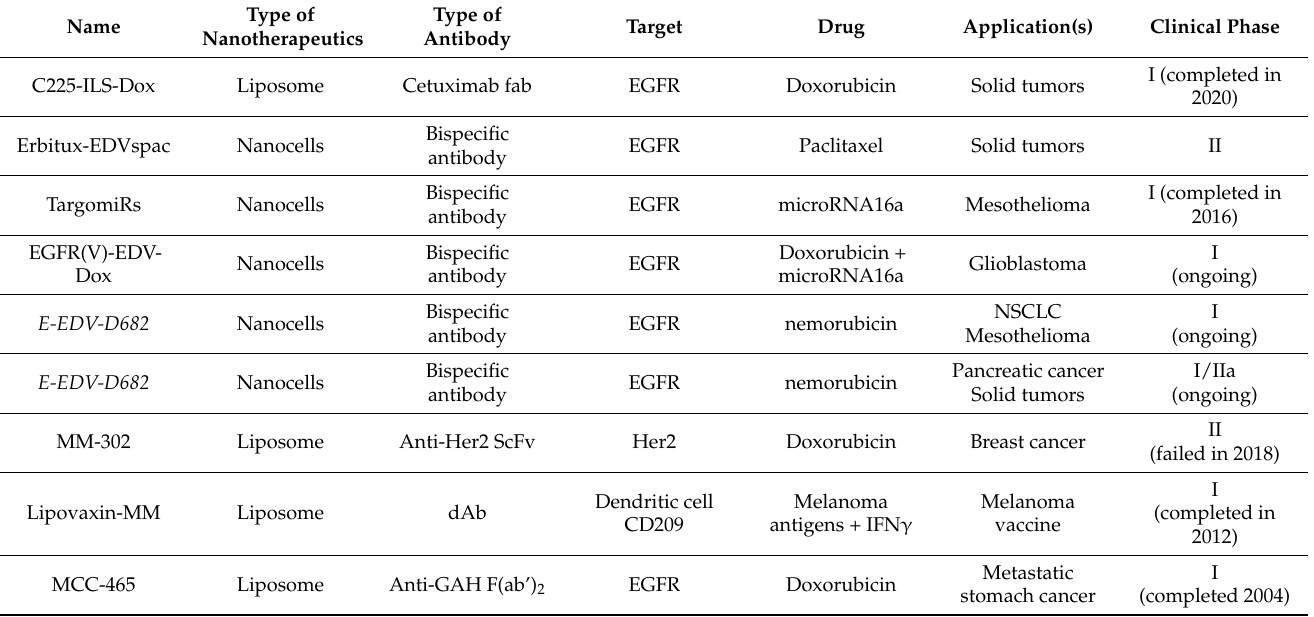
Table 4. Summary of the most relevant clinical trials in oncology evaluating nanoparticles grafted with antibodies or fragment of antibodies. Adapted from Richards et al.